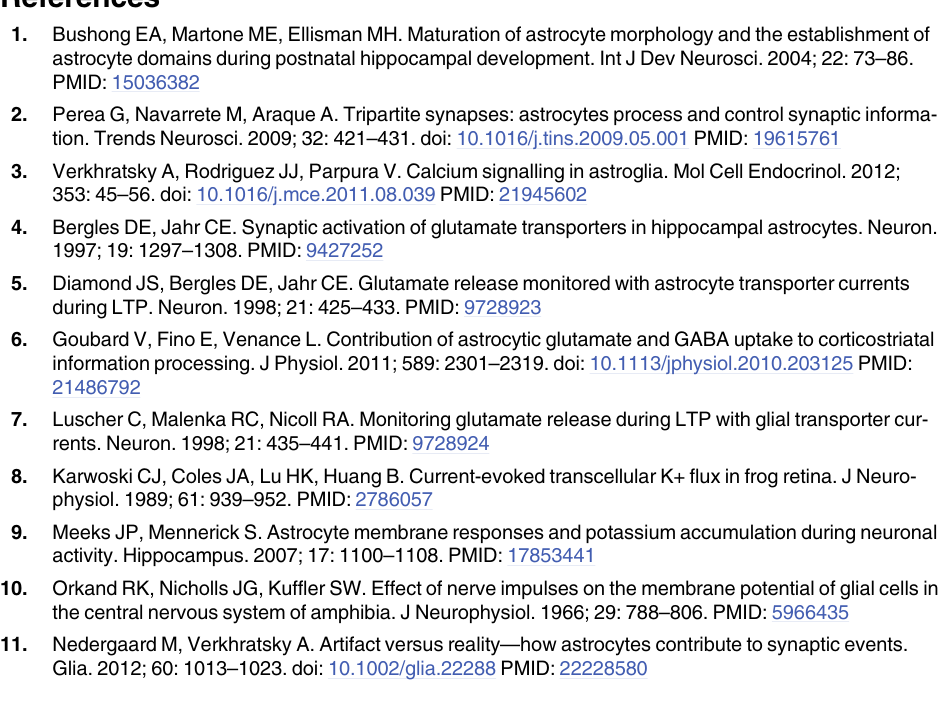
S1 Fig. Neuronal firing and extracellular K + transients evoked by neuronal stimulations. ( B , D , F ) in control conditions (blue) following sin- Simulated neuronal firing ( A , C , E ) and [K + ] o gle ( A , B ), tetanic (100 Hz, 1 s) ( C , D ) and repetitive (10 Hz, 30 s) ( E , F ) stimulations. S2 Fig. Astroglial net potassium uptake changes with extracellular K + levels. A-C ) Astroglial evoked by single (light net K + uptake (equation 27) and activity-dependent changes in [K + ] o blue), tetanic (100 Hz, 1s, green) and repetitive (10 Hz, 30 s, dark blue) stimulations are plotted as a function of time. D ) Phase diagram illustrating astroglial K + uptake as a dynamic function evoked by the different stimulations. Astroglial K + net of activity-dependent changes in [K + ] o uptake is normalized to the maximum value obtained during repetitive